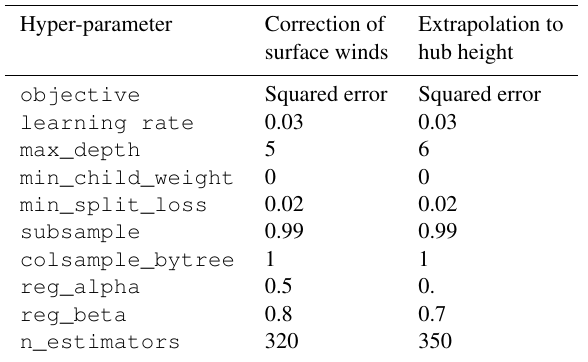
Table 3. Gradient boosting hyper-parameters optimized with grid search with